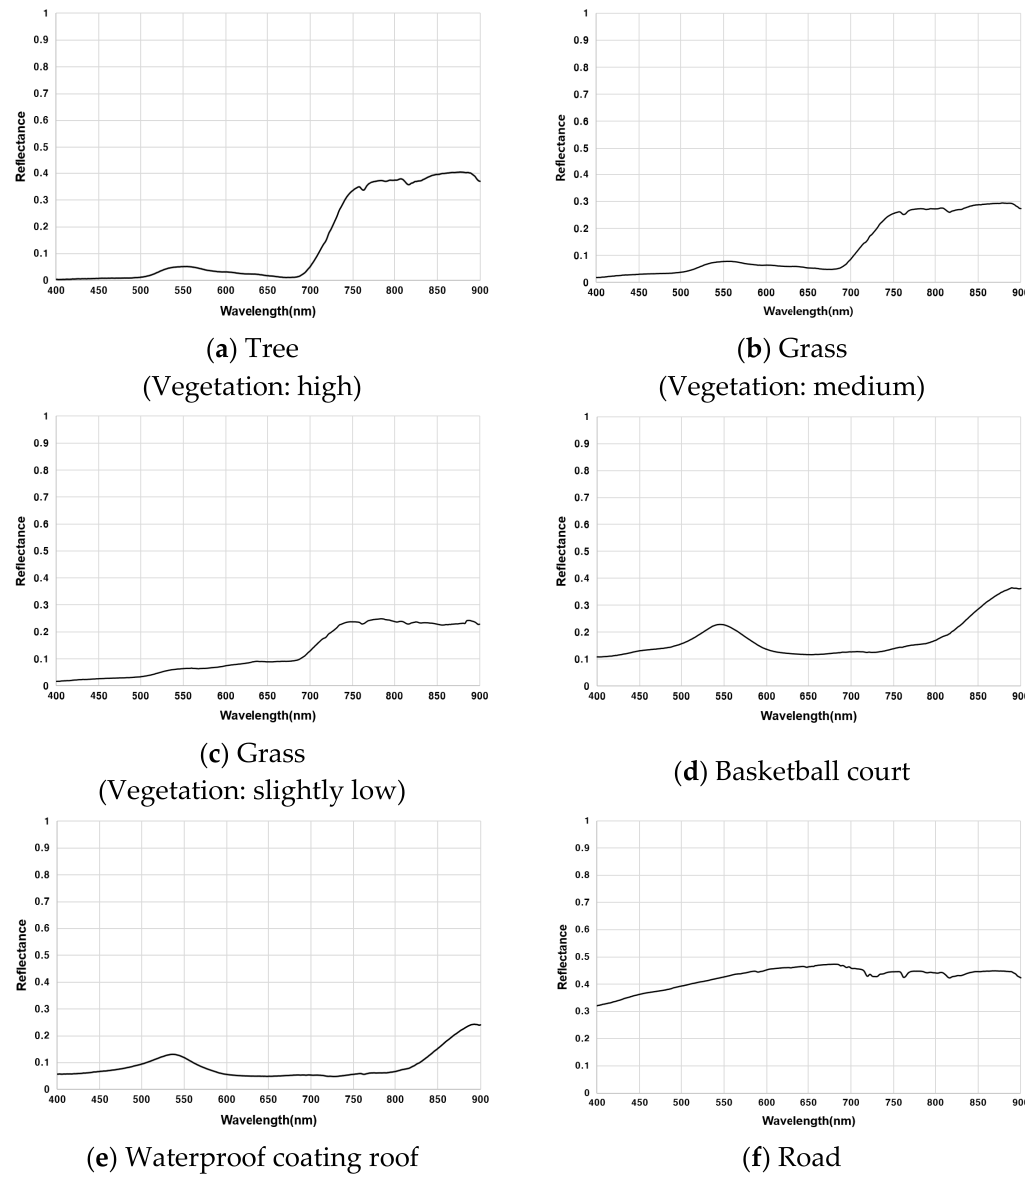
Figure 14. Reflectance by wavelength using ASD FieldSpec4 spectrometer. Table 7. Reflectance by bands (R, G, B and Nir) and NDVI for each land cover using ASD FieldSpec4 spectrometer.